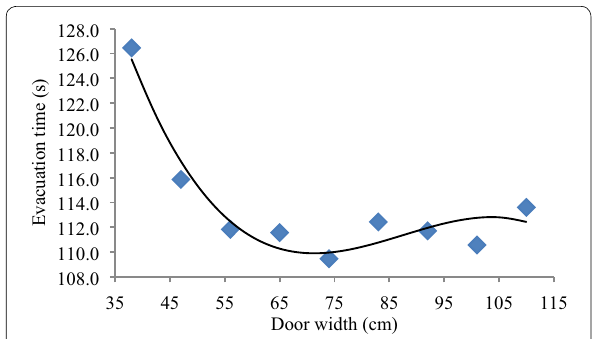
Figure 12 Fitting curve of evacuation time and door